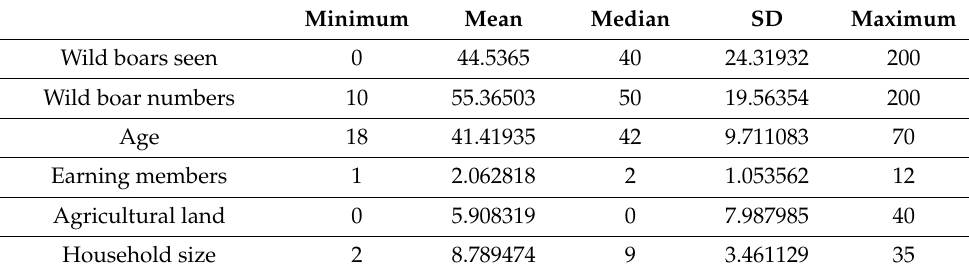
Table 7. Factors associated with attitudes towards wild boars ( n = 589). The values shown include the means, medians, standard deviations, minimums, and maximums of the continuous factors used in the GLM model.